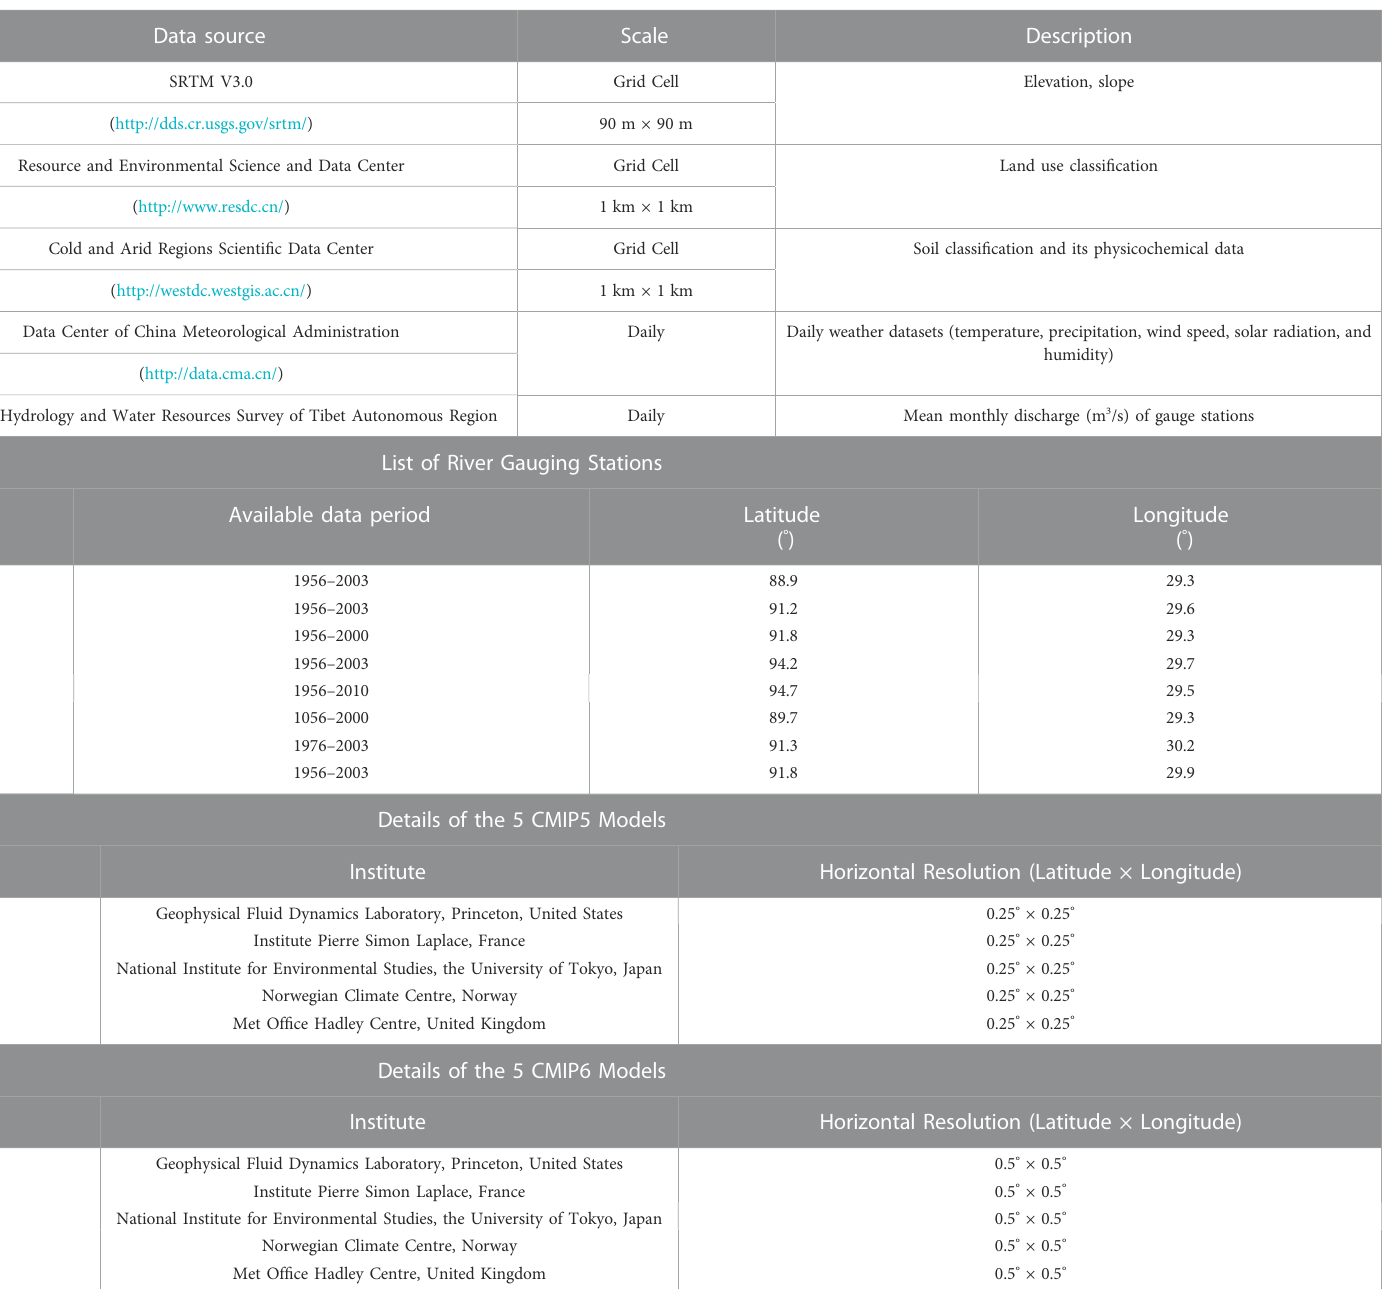
TABLE 1 Data source